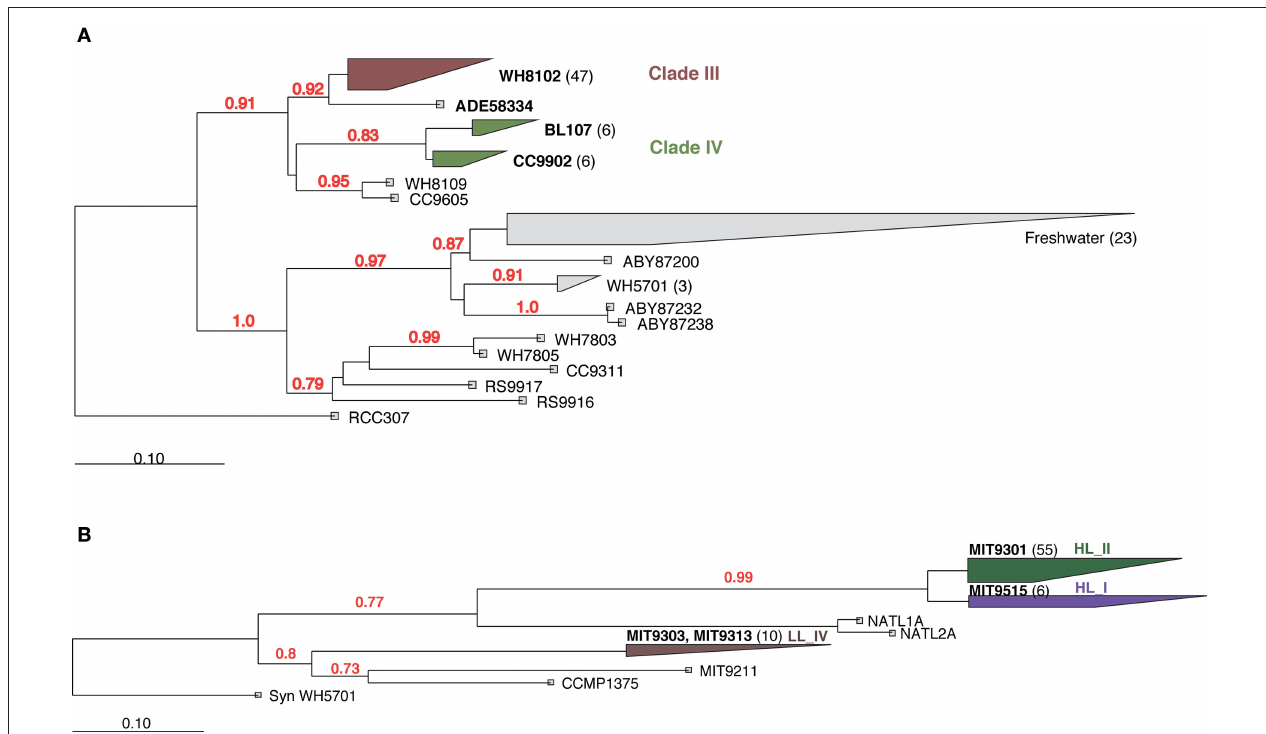
FIgure 5 | Neighbor joining phylogenetic analysis of Synechococcus (A) and Prochlorococcus (B) PhnD protein regions. A region of 187 aa for Synechococcus and 64 aa for Prochlorococcus was analyzed. Bootstrap values > 70% are shown. Number of unique (less than 98% aa similarity) sequences obtained in this and previous studies are shown in